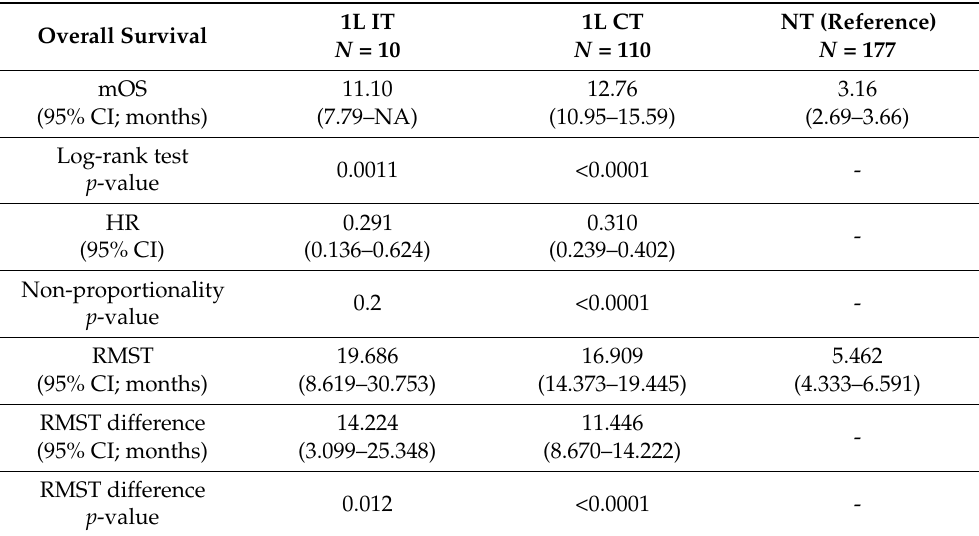
Table A2. Median overall survival from time of metastasis for first-line palliative systemic treatments versus no treatment.